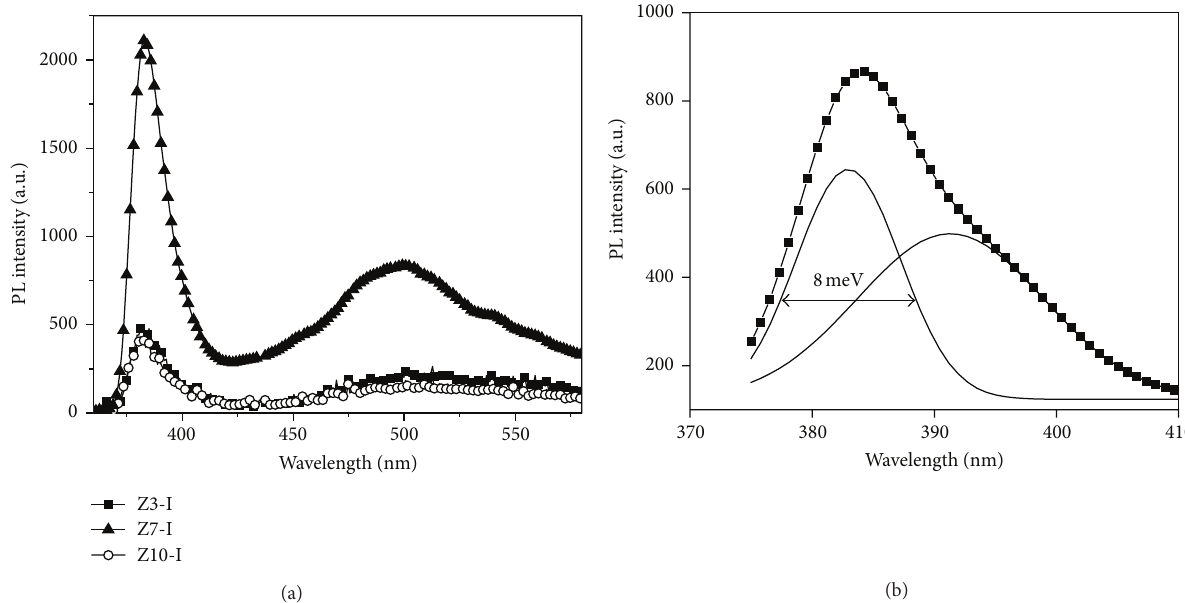
Figure 5: (a) PL spectrum of ZnO thin films prepared at different spray rates. (b) Gaussian fitting and FWHM of the NBE peak at 3.26 eV.